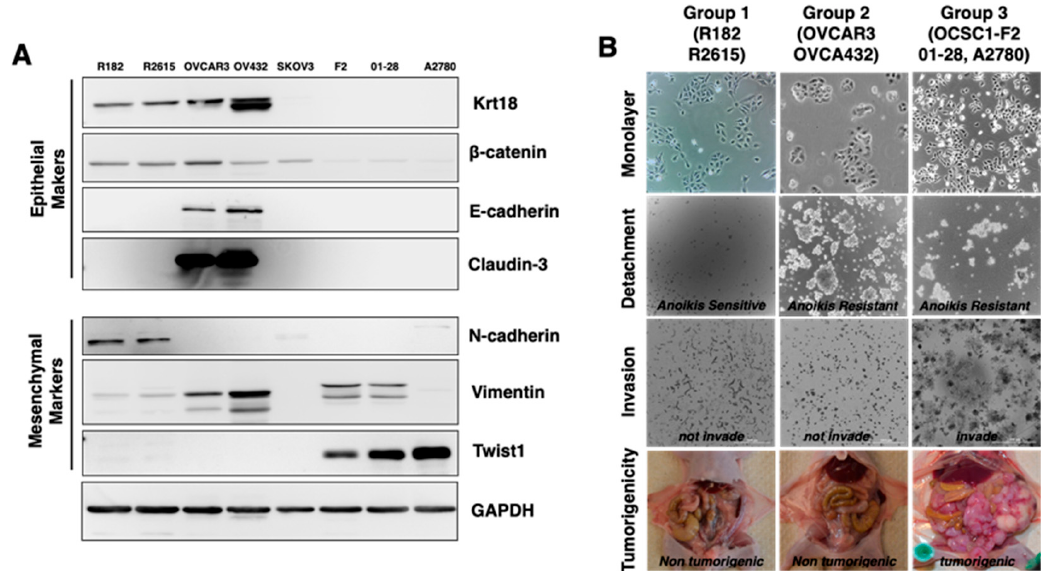
Figure 1. Characterization of the epithelial–mesenchymal molecular and biological phenotypes in ovarian cancer cell lines. ( A ) The EMT molecular characterization was achieved using Western blot with Keratin-18 (Krt-18), β -catenin, E-cadherin, Claudin-3 as the epithelial markers and N-cadherin, Vimentin, and Twist1 as the mesenchymal markers. GAPDH was used as the loading control. ( B )